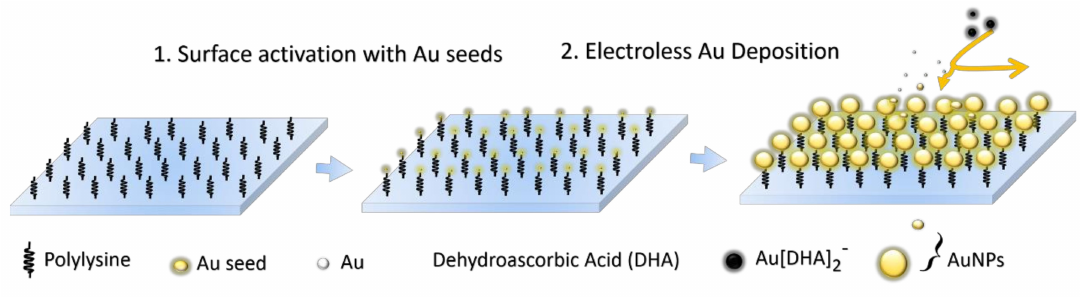
Figure 1. Schematic diagram of fabrication of Au nanoparticle films as uniform SERS-active substrates by SMED